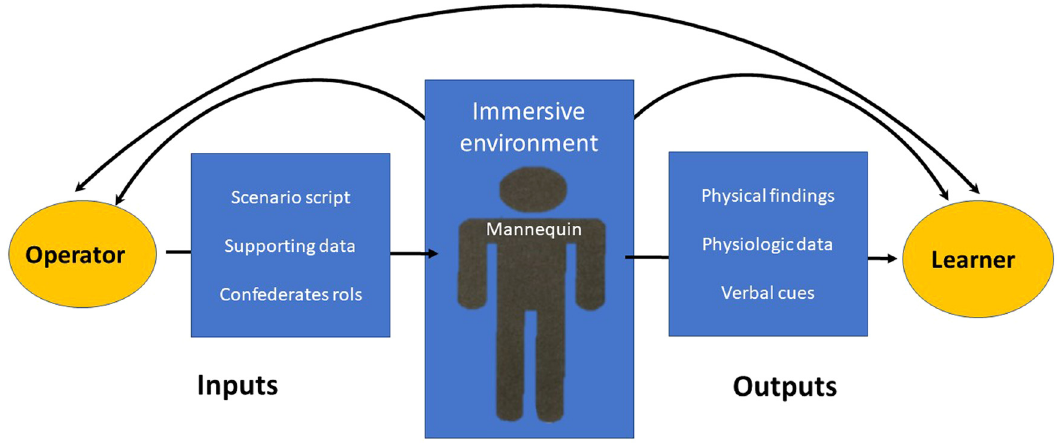
Figure 3: Mannequin - based simulators placed in the larger simulation context which includes an immersive environment, inputs and outputs, and an operator learner pairing ( with permission of Springer Nature ) [ 26, p. 210